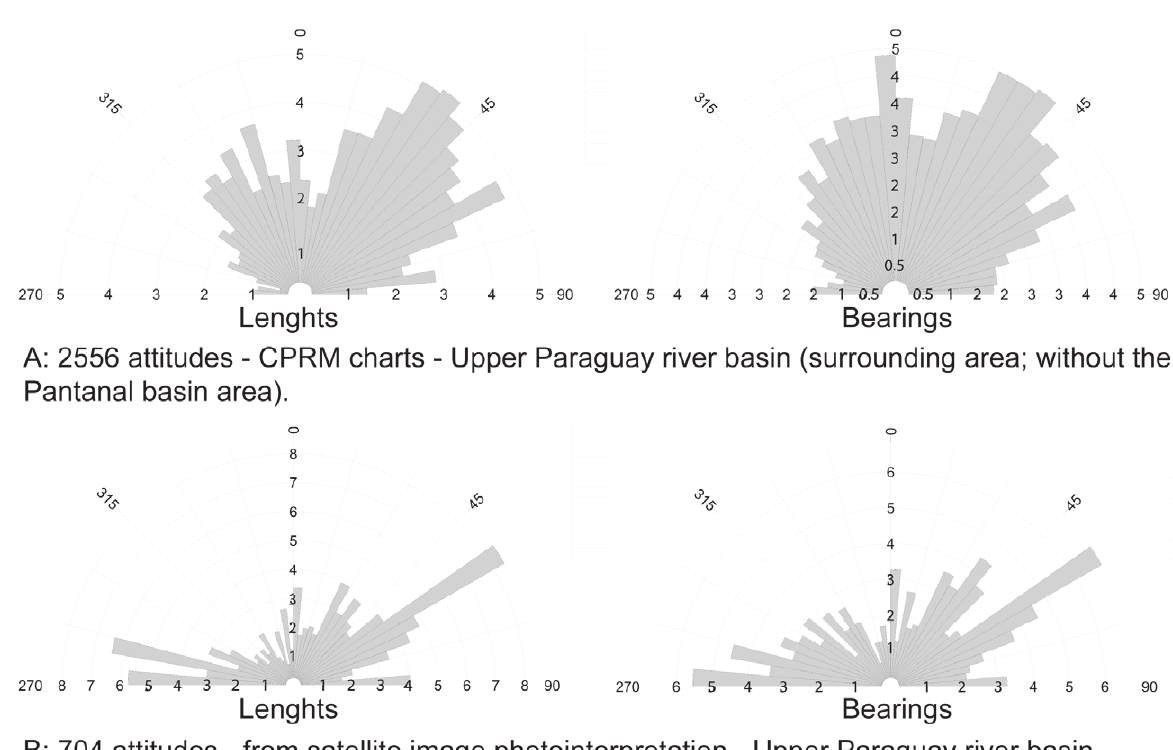
Figure 4 - Rose diagrams with the lineaments from CPRM (A) and from the photointerpretation of the satellite image (B) . No stronger trend is depicted in “A”, except for a suggestion of NE and NS structures. The rose diagrams with length-proportional frequency show the importance of the NE direction, which is associated with the Transbrasiliano Lineament. There are two important systems marked on B: one trending ENE and the other trending almost